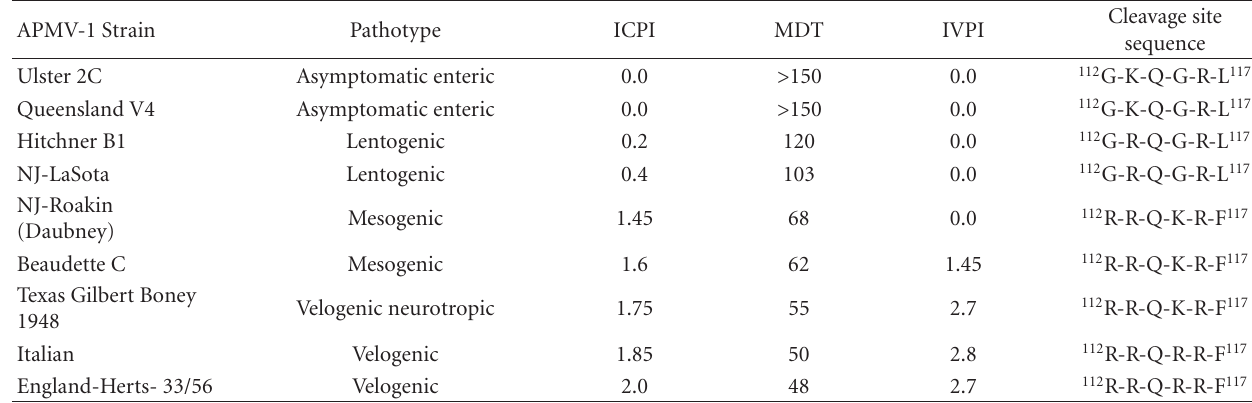
Table 1: Examples of ICPI, MDT, IVPI, and cleavage site for some strains of